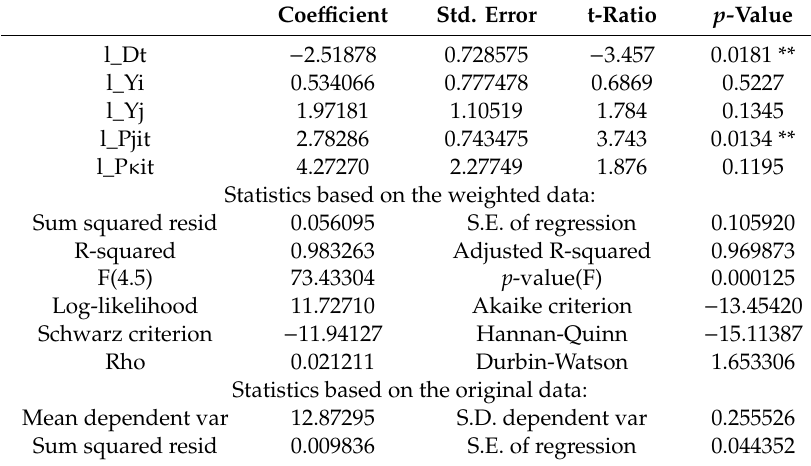
Table 10. FGLS estimation of total amount of Hungarian tourists in Croatia—general model. Model 1: FGLS, using observations 2009–2018 (T = 10); dependent variable: l_TAji; variable used as weight: l_Dt.